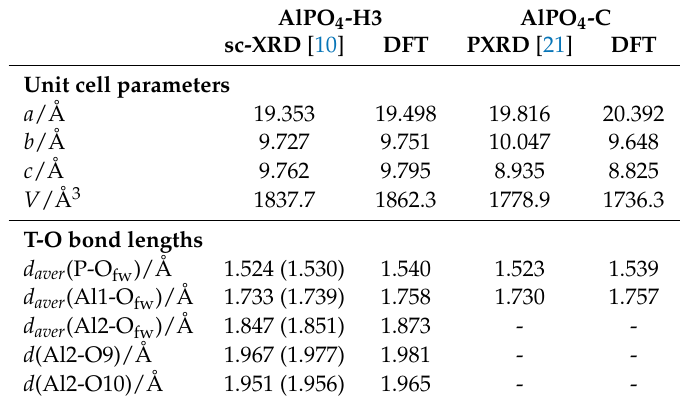
Table 1. Comparison of experimental and DFT-optimised lattice parameters and T-O bond distances for AlPO 4 -H3 and AlPO 4 -C. For T-O bonds in AlPO 4 -H3, SRB-corrected values of the experimental bond lengths are given in brackets. d aver represents averages over several bonds, O fw designates framework oxygen atoms. AlPO 4 -H3 AlPO 4 -C sc-XRD [10] DFT PXRD [21] DFT Unit cell parameters a /Å 19.353 19.498 19.816 20.392 b /Å 9.727 9.751 10.047 9.648 9.762 9.795 1837.7 1862.3 1778.9 1736.3